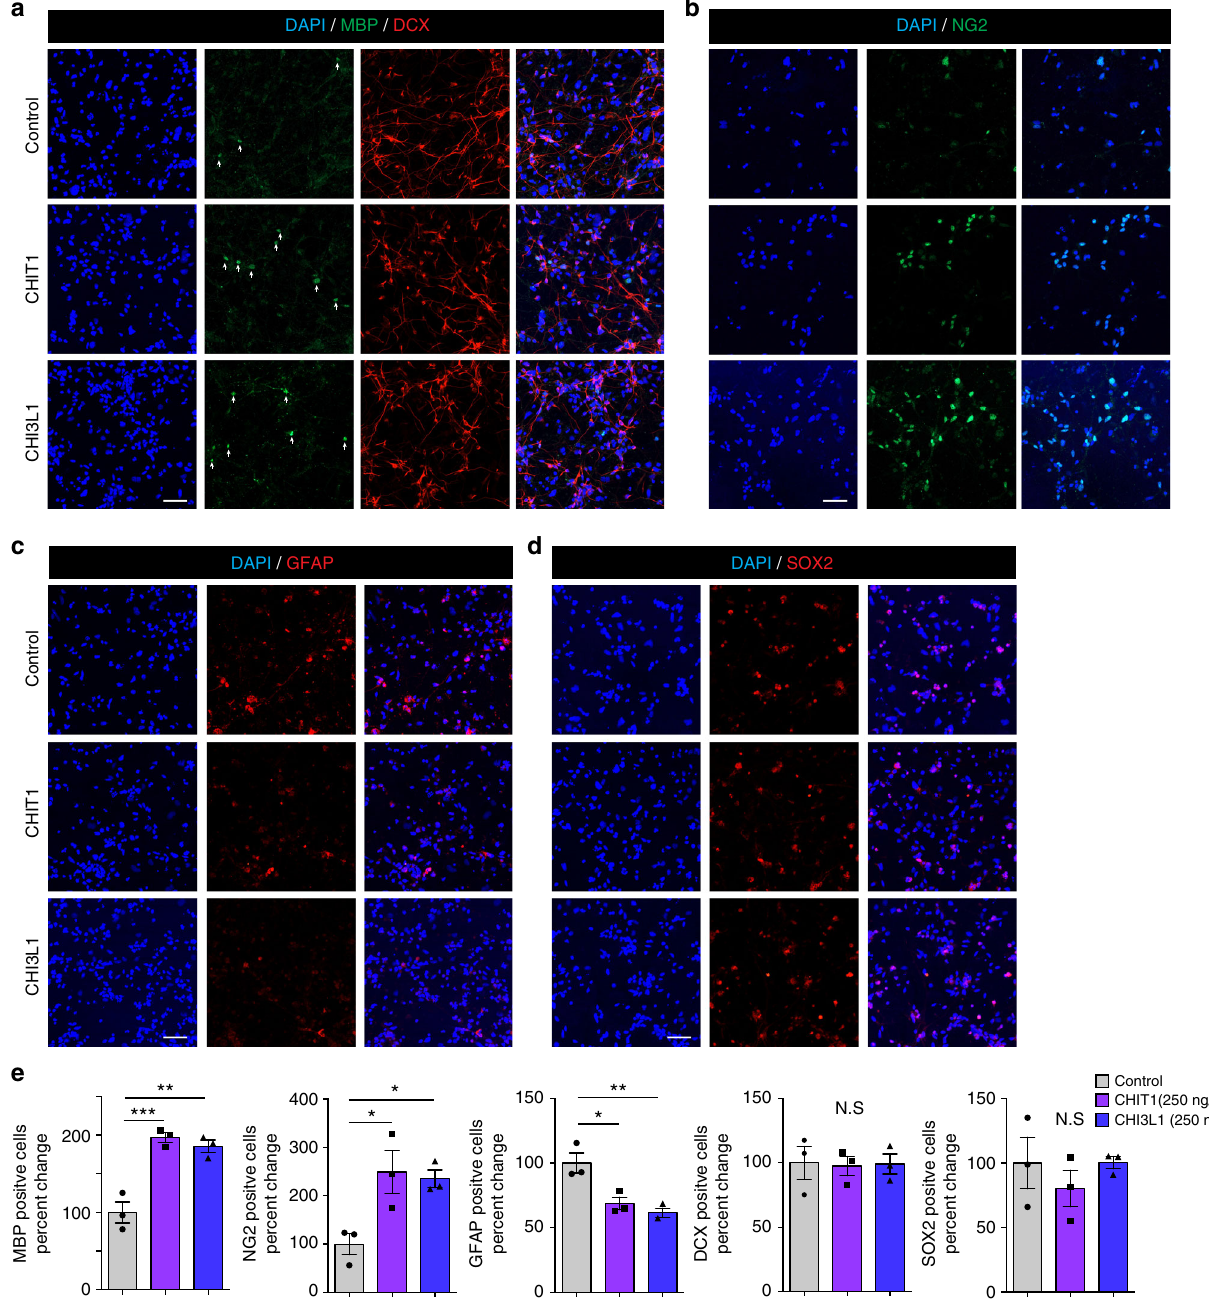
Fig. 7 Human CLPs directly promote oligodendrogenesis. Human neural stem cells (NSCs) were cultured in the presence of PBS (control), human CHI3L1 and human CHIT1 at 250 ng/ml for 14 days. a – c Cells were immunostained for MBP ( a , oligodendrocytes, green), DCX ( a , neurons, red), NG2 ( b , OPC, green), GFAP ( c , astrocyte, red), SOX2 ( d , NSC, red) and nuclear stain DAPI (blue). Scale bar, 50 μ m. e Quanti fi cation of MBP + , NG2 + , GFAP + , DCX + , and SOX2 + NSCs after exposure to human Chi3L1or human Chit1. Exposure of differentiating NSCs to CHI3L1 and CHIT1 led to signi fi cant increase in oligodendrogenesis. Values are expressed as percent change to PBS-treated NSCs (data are representative of three independent experiments. one-way ANOVA with Dunnett ’ s multiple comparison test; mean ± s.e.m * p < 0.05; ** p < 0.01; *** p < 0.005; N.S. = not signi fi